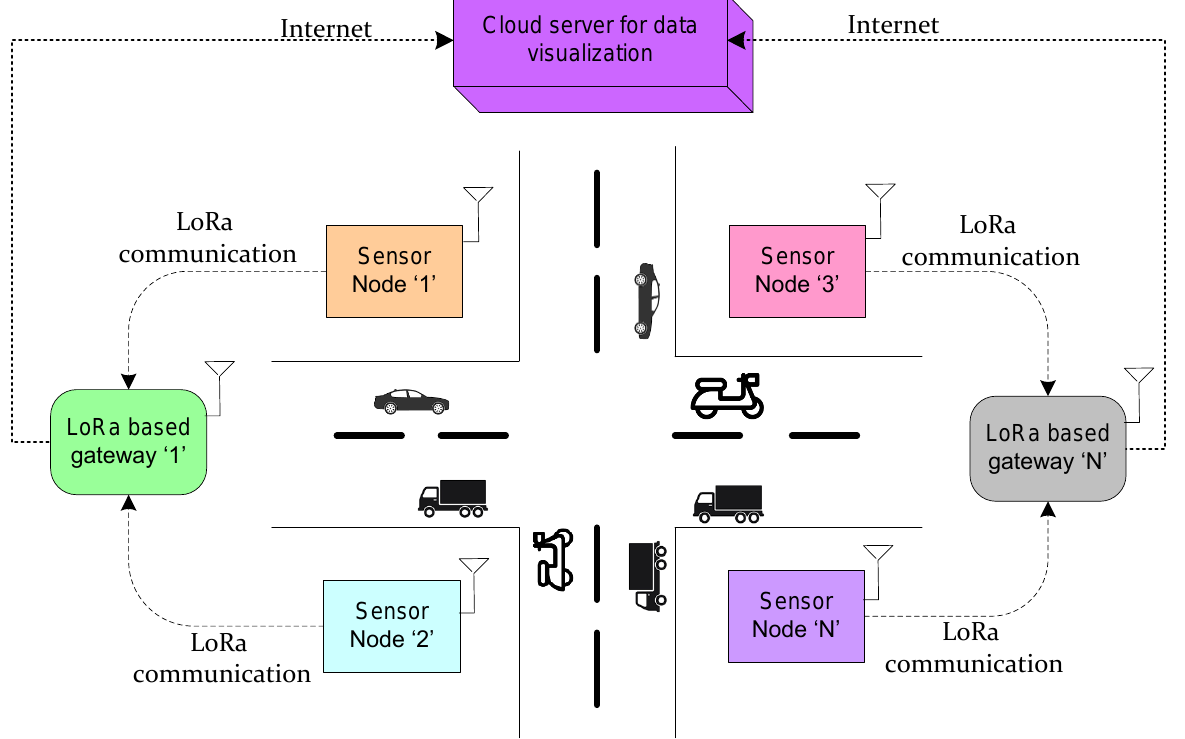
Figure 3. General architecture of the proposed system.